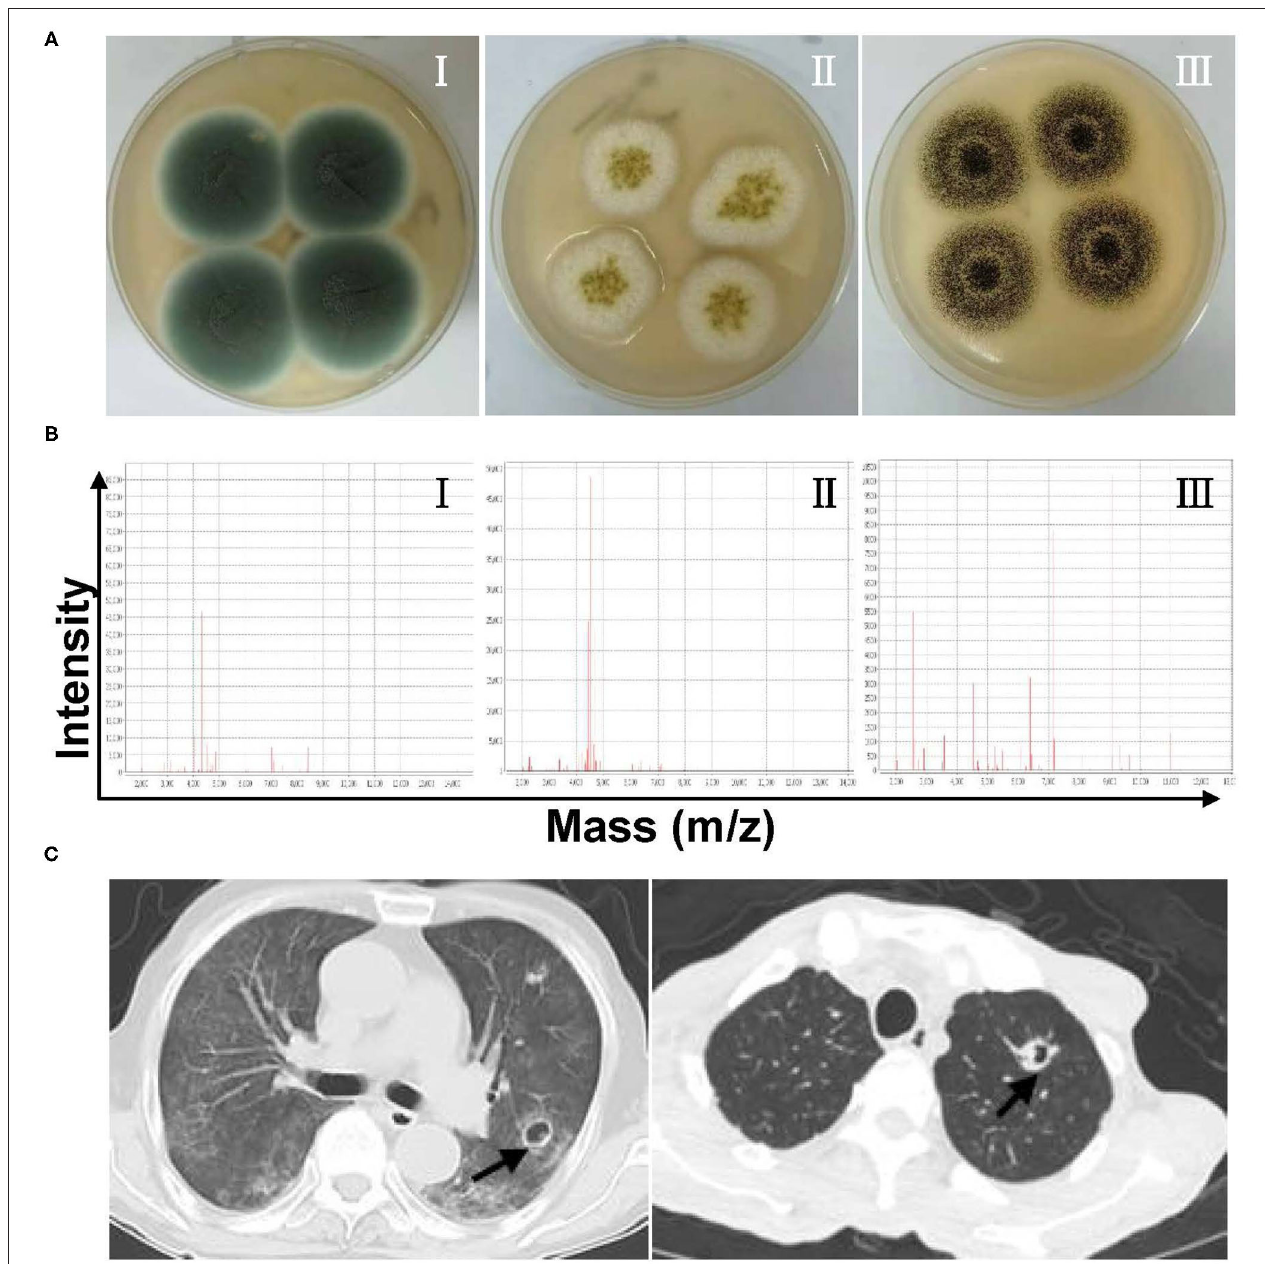
FIGURE 1 | (A) Representative culturing macroscopic results of Aspergillus spp. (Sabouraud Dextrose agar medium). I–III: Aspergillus fumigatus , Aspergillus flavus , and Aspergillus niger . (B) Representative identification information of Aspergillus spp. by matrix-assisted laser desorption ionization-time of flight mass spectrometry (MALDI-TOF MS). I–III: A. fumigatus , A. flavus, and A. niger . (C) Chest CT imaging features of patients with invasive pulmonary aspergillosis.